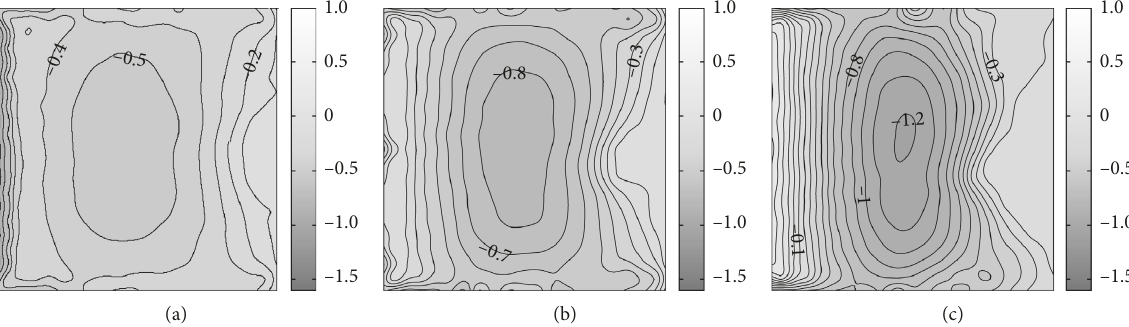
Figure 12: Contours of mean pressure coefficients on cylindrical roofs with different rise-to-span ratios. (a) R / S � 1/10. (b) R / S � 1/6.25. (c) R / S �